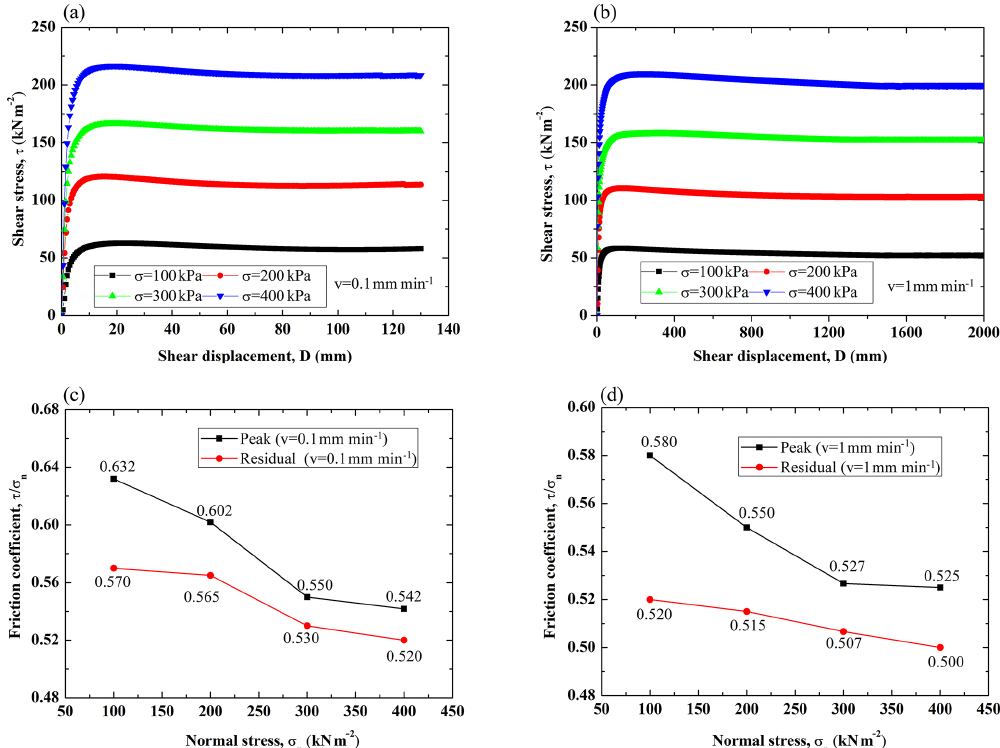
Figure 5. Shear behavior characteristics of YDG soil samples. (a) Relationship between shear stress and shear displacement. (b) Relationship between friction coefficient and normal